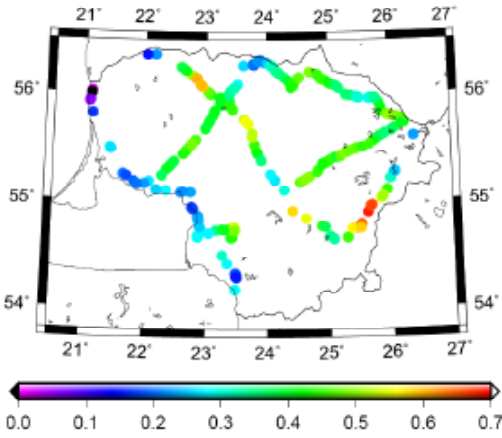
Fig. 5 . Distribution of the “new” set of Lithuanian GPS- levelling data (altogether 223 points) and their differences from the EIGEN-GL04c geoidal heights (developed up to degree 360). The discrepancies ( N geom – EIGEN N ) range from 2;360 –0.01 to +0.68 m, with a mean of +0.376 m. The STD of the discrepancies amounts to 0.123 m. The colors of the data-points are proportional to the range of the detected discrepancies (cf. the colorbar). The unit is metre. The levellings are referred to the Amsterdam tide-gauge